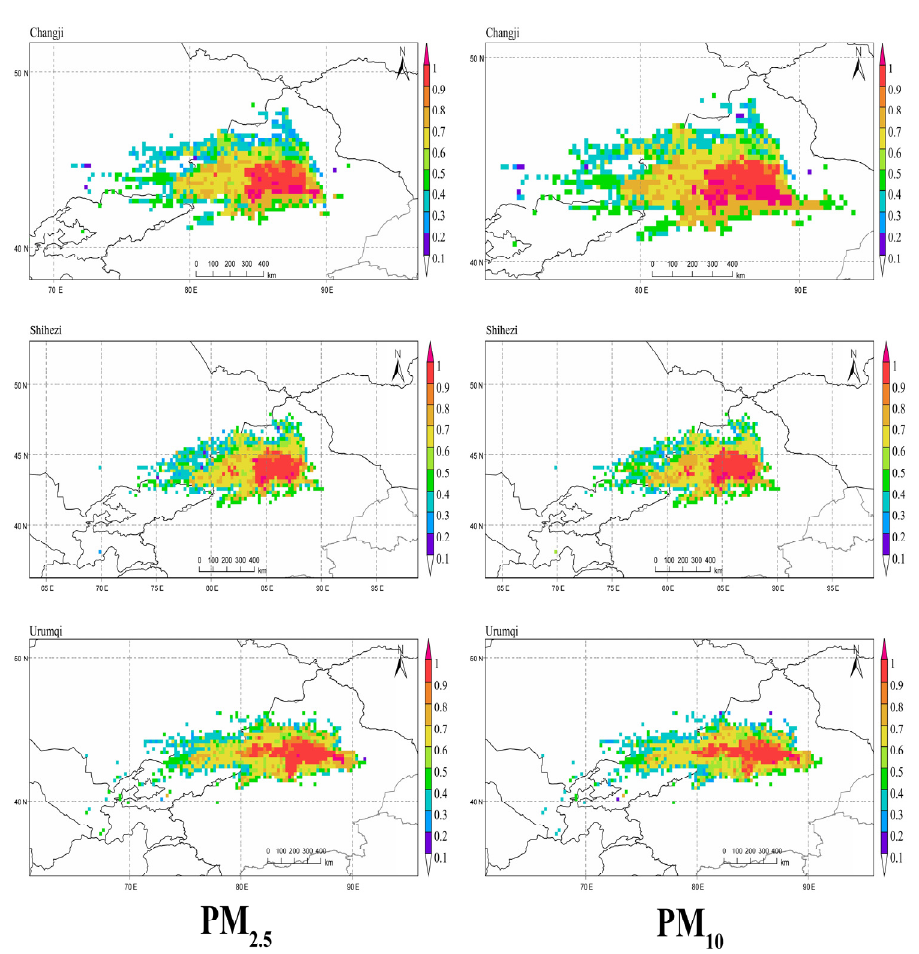
Figure 6. PSCF distribution of winter particulate matter in the Wu-Chang-Shi urban.